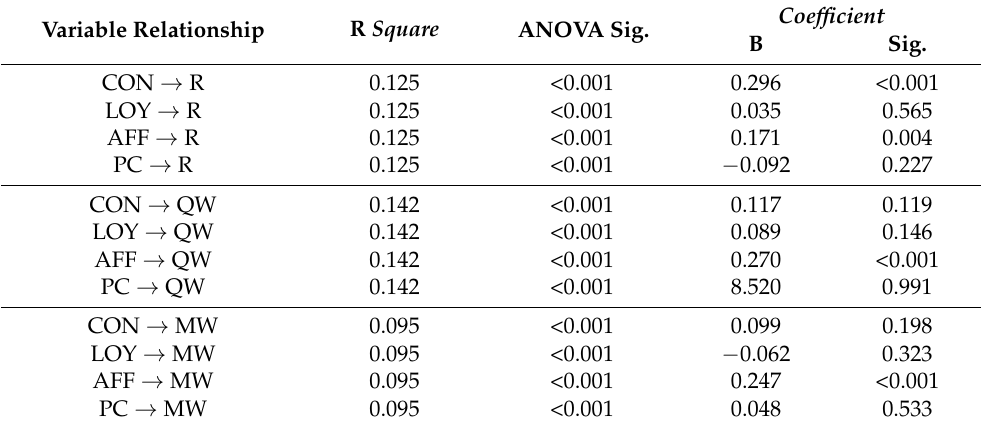
Table 4. Multiple linear regression test of leader–member exchange and subjective career success. Variable Relationship R Square ANOVA